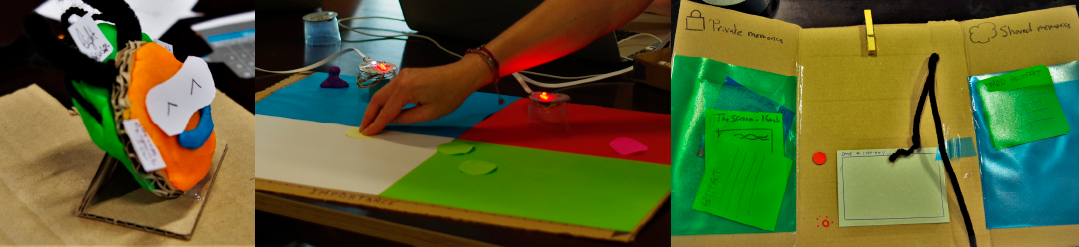
Figure 7. Cardboard prototypes of Tangigotchi ( left ) and MuseumMemories ( right ); hardware prototype of Eisenhower ( centre ).